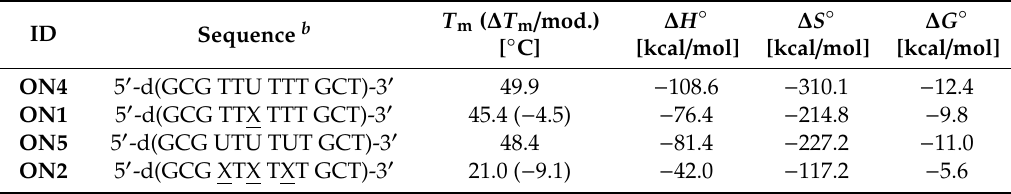
Table 2. T m values and thermodynamic parameters of duplexes formed between oligonucleotides and the complementary single-stranded DNA (ssDNA) a .